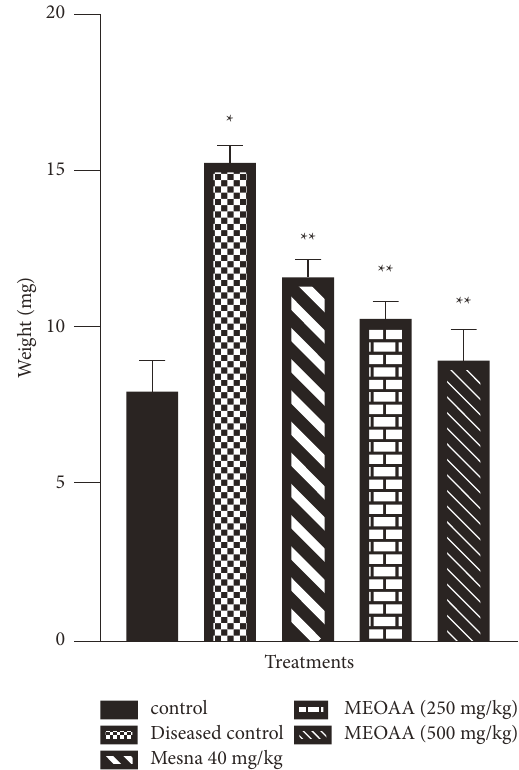
Figure 1: Data have been presented as mean ± SEM. Evaluation of weight of the bladder for control, diseased control (cyclophos- phamide 150mg/kg), standard drug (Mesna 40mg/kg)-treated, and methanolic extract of A arvensis (MEOAA) (250 mg/kg and 500mg/kg)-treated group of rats. ( ∗ P < 0 . 05 compared to the control group, ∗∗ P < 0 . 05 compared to the diseased control group; n �